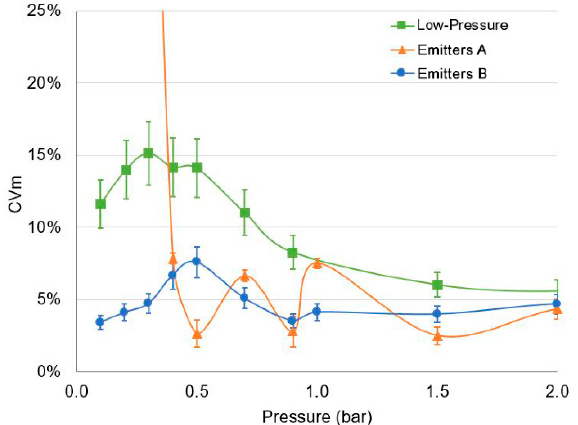
Figure 10. Manufacturing coe ffi cient of variation ( CV m ) of the three types of low-pressure and conventional emitters used in field trials, as measured in lab tests ( n = 25 for each type of emitter), computed per Equation (5) for a range of inlet pressures, and plotted with the standard error of CV [34]. The high CV m of emitters A at 30 kPa (0.3 bar) ( CV m = 57%; not shown in plot) is due to variation in shut-o ff pressure for the non-leakage feature, leading to a high standard deviation at a low mean flow rate.